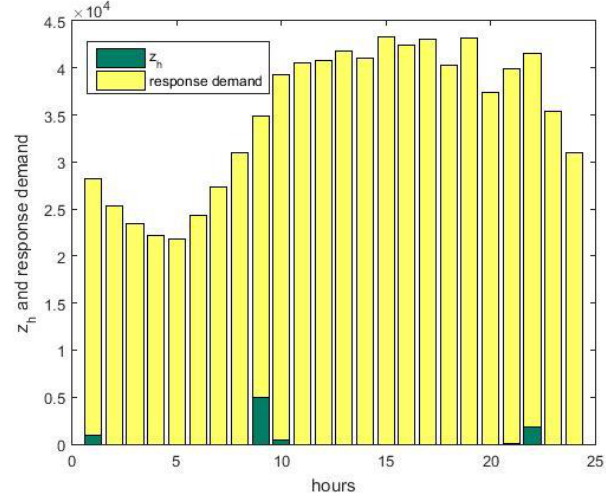
Figure 8. The customers’ demand and 𝑧 ℎ .